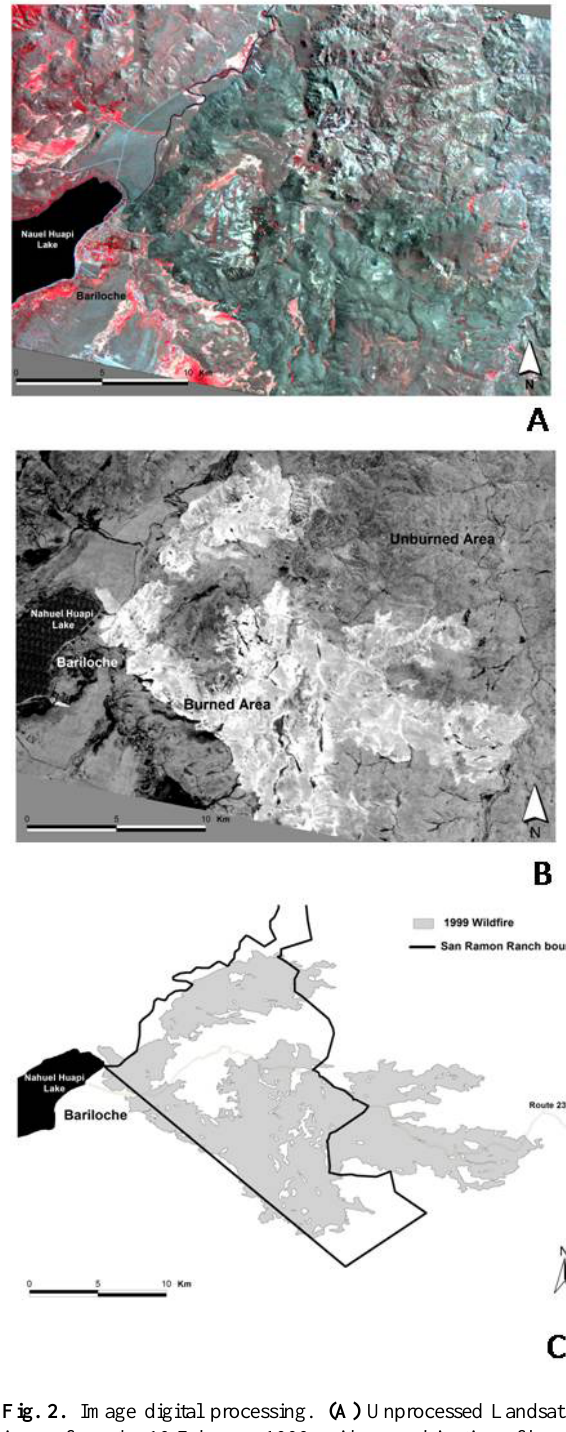
Fig. 2. Image digital processing. (A) Unprocessed Landsat TM image from the 10 February 1999, with a combination of bands 4, 3 and 2. (B) Landsat TM image from 10 February 1999, after the NBR index was calculated (C) Fire data in shape file data format. This figure shows the area damaged by fire in relation to the ranch